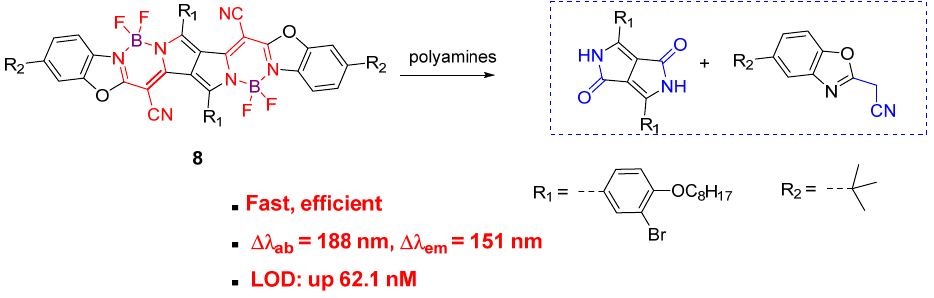
Figure 9. The possible sensing mechanism between compound 8 and the polyamines [64].